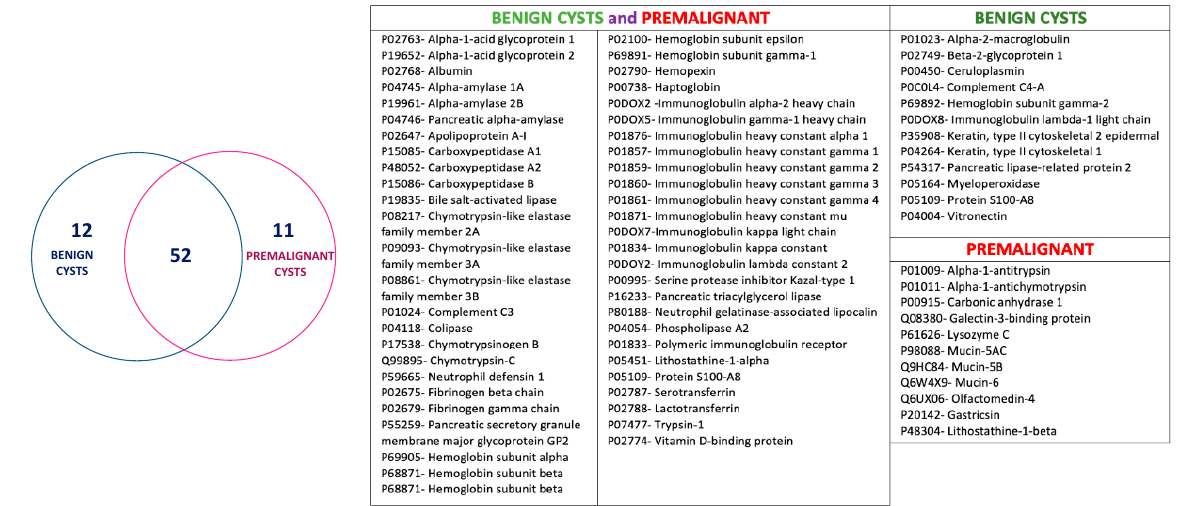
Figure 3. LC-ESI-MS/MS proteomic content of cystic samples. Common proteins were analyzed via Venn diagrams online tool (http://bioinformatics.psb.ugent.be/beg/tools/venn-diagrams). 12 and 11 proteins were detected only in benign cysts (blue) and premalignant cysts (pink), respectively, and 52 proteins appeared in both groups (intersection set). Table comprises the detailed information of the proteins in each set.